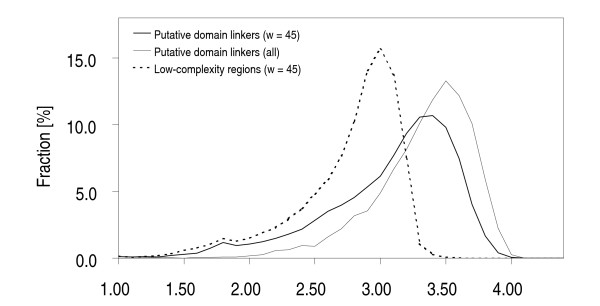
Complexity distribution. The sequence entropy distributions are shown for the putative domain linkers (thick solid line) and the low-complexity regions (thick broken line) longer than 45 residues. The sequence entropy was calculated by a sliding window of 45 residues over the putative domain linkers [43, 51]. The thin solid line represents the sequence entropy of all of the putative domain linkers (including those shorter than 45 residues) calculated with a window equal to the length of the linker.